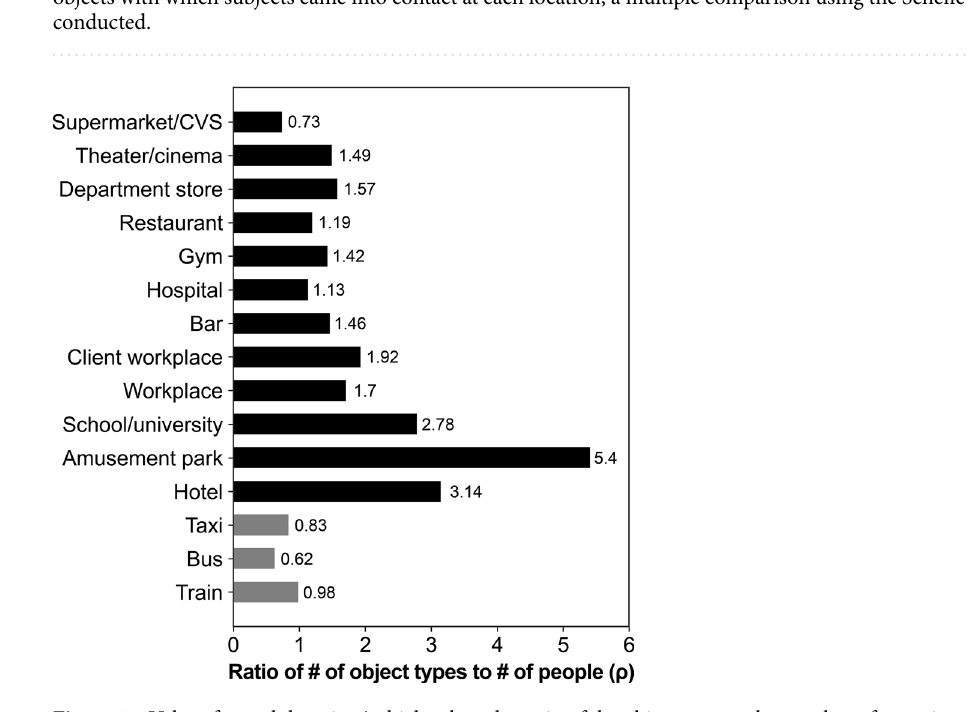
Figure 5. Values for each location/vehicle when the ratio of the object type to the number of users is expressed using ρ . Higher ratios indicate an increase in the type of objects that can be touched per person in a given location, which means that more objects would need to be disinfected. In contrast, low ratios indicate few types of objects per person. Thus, many individuals may touch the same objects, and the number of objects that need to be disinfected is